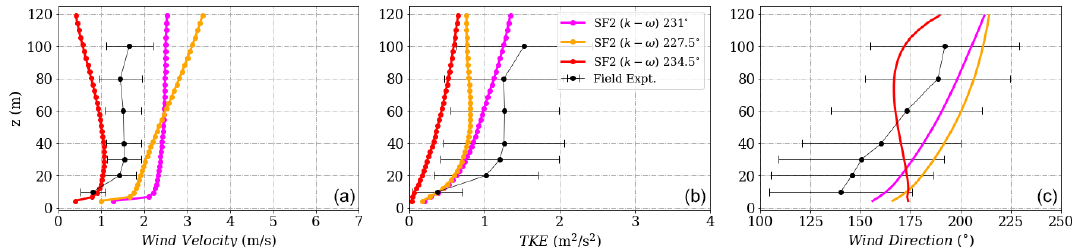
Figure D2. (a) Wind velocity magnitude, (b) wind direction and (c) turbulent kinetic energy at Tower 25 (tse09) for the SF2 ( k − ω ) model.